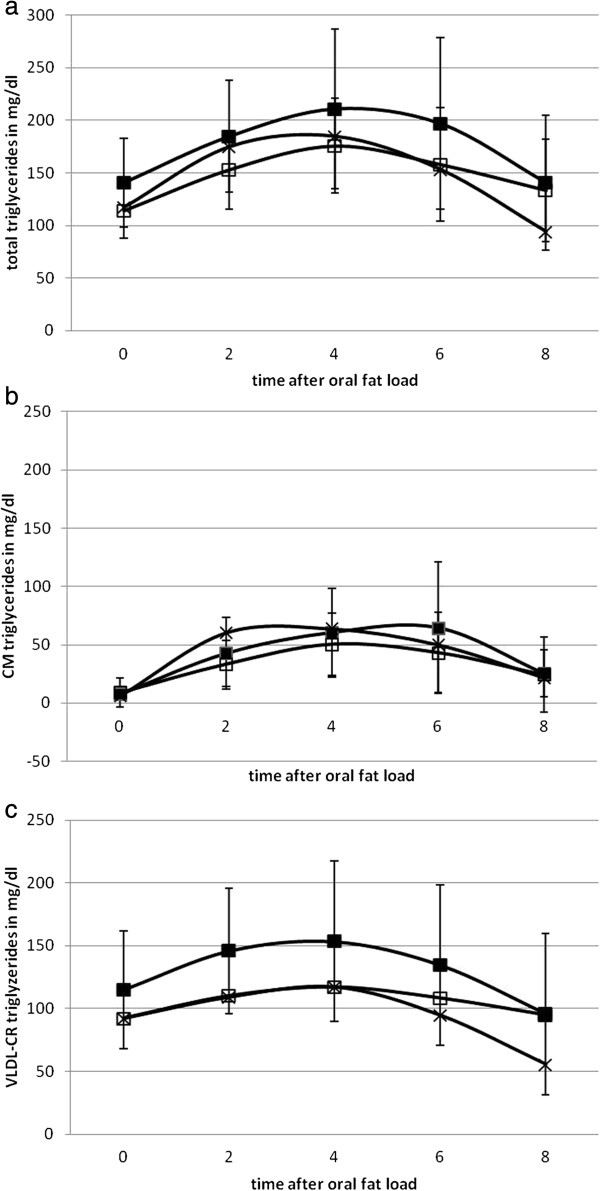
Means (± SD) of plasma - (a), CM- (b) and VLDL/CR- (c) TGs following the oral fat load. Filled and unfilled symbols represent data obtained before and after bariatric surgery. Crosses symbol control group.